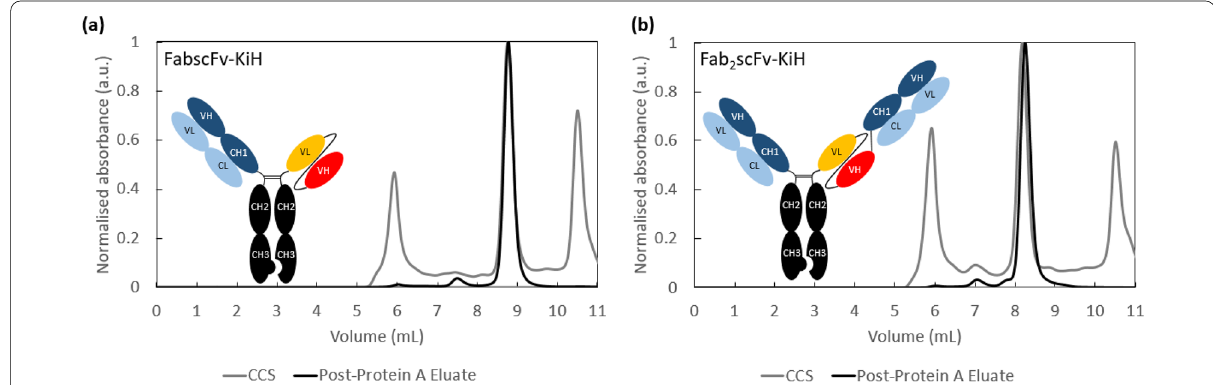
Fig. 1 Schematic representation of model bsAbs—FabscFv-KiH ( a ) and Fab 2 scFv-KiH ( b )—used in this study, along with their representative HPLC-SEC purity profiles of cell culture supernatant (CCS) and post-Protein A eluates